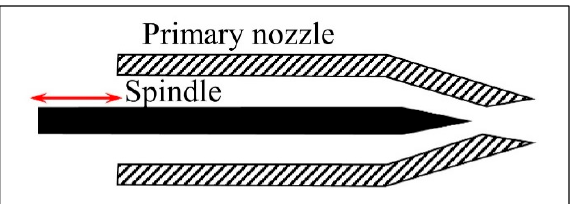
Figure 14. Variable geometry ejector (VGE).